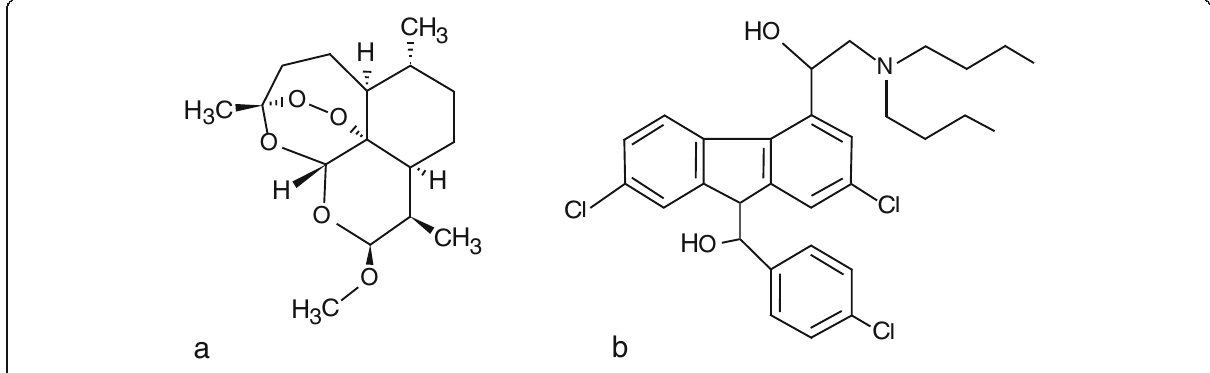
Fig. 2 Chemical structure of Coartem. Artemether has the empirical formula of C 16 H 26 O 5 ( a ). C 46 H 58 Cl 3 NO 6 for Lumefantrine ( b